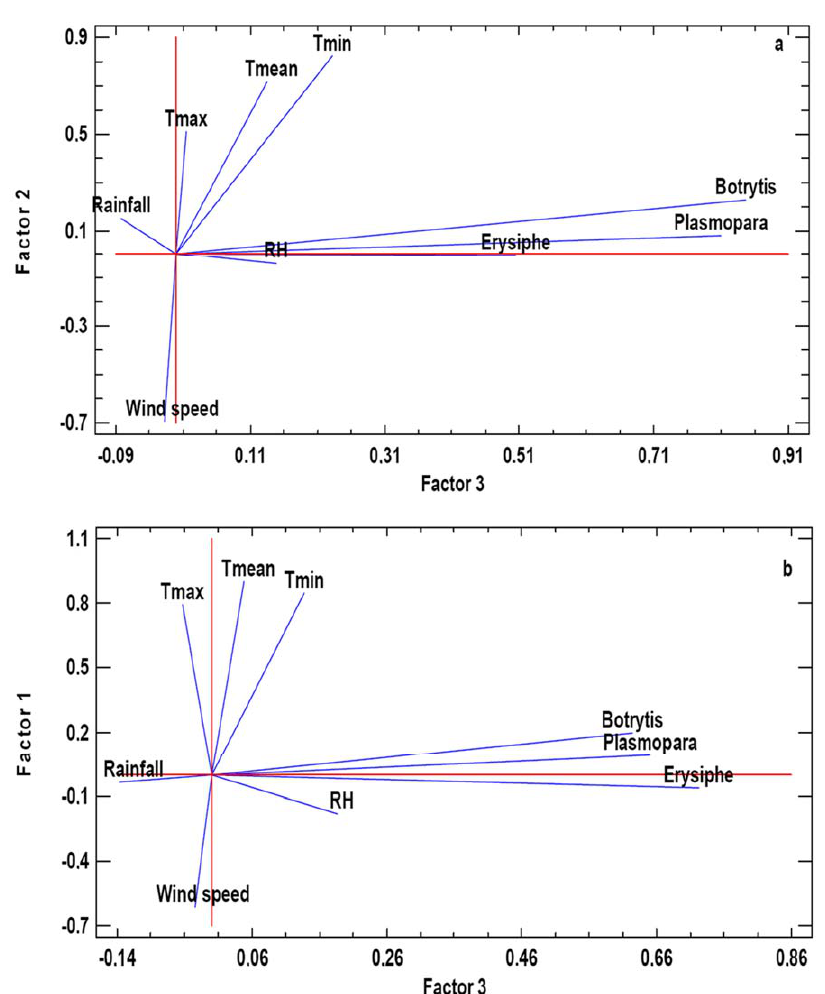
Figure 3. Graphical representation of the Principal Components Analysis (PCA). a : PC2 vs. PC3 in Cenlle, b : PC1 vs. PC3 in o Mato.